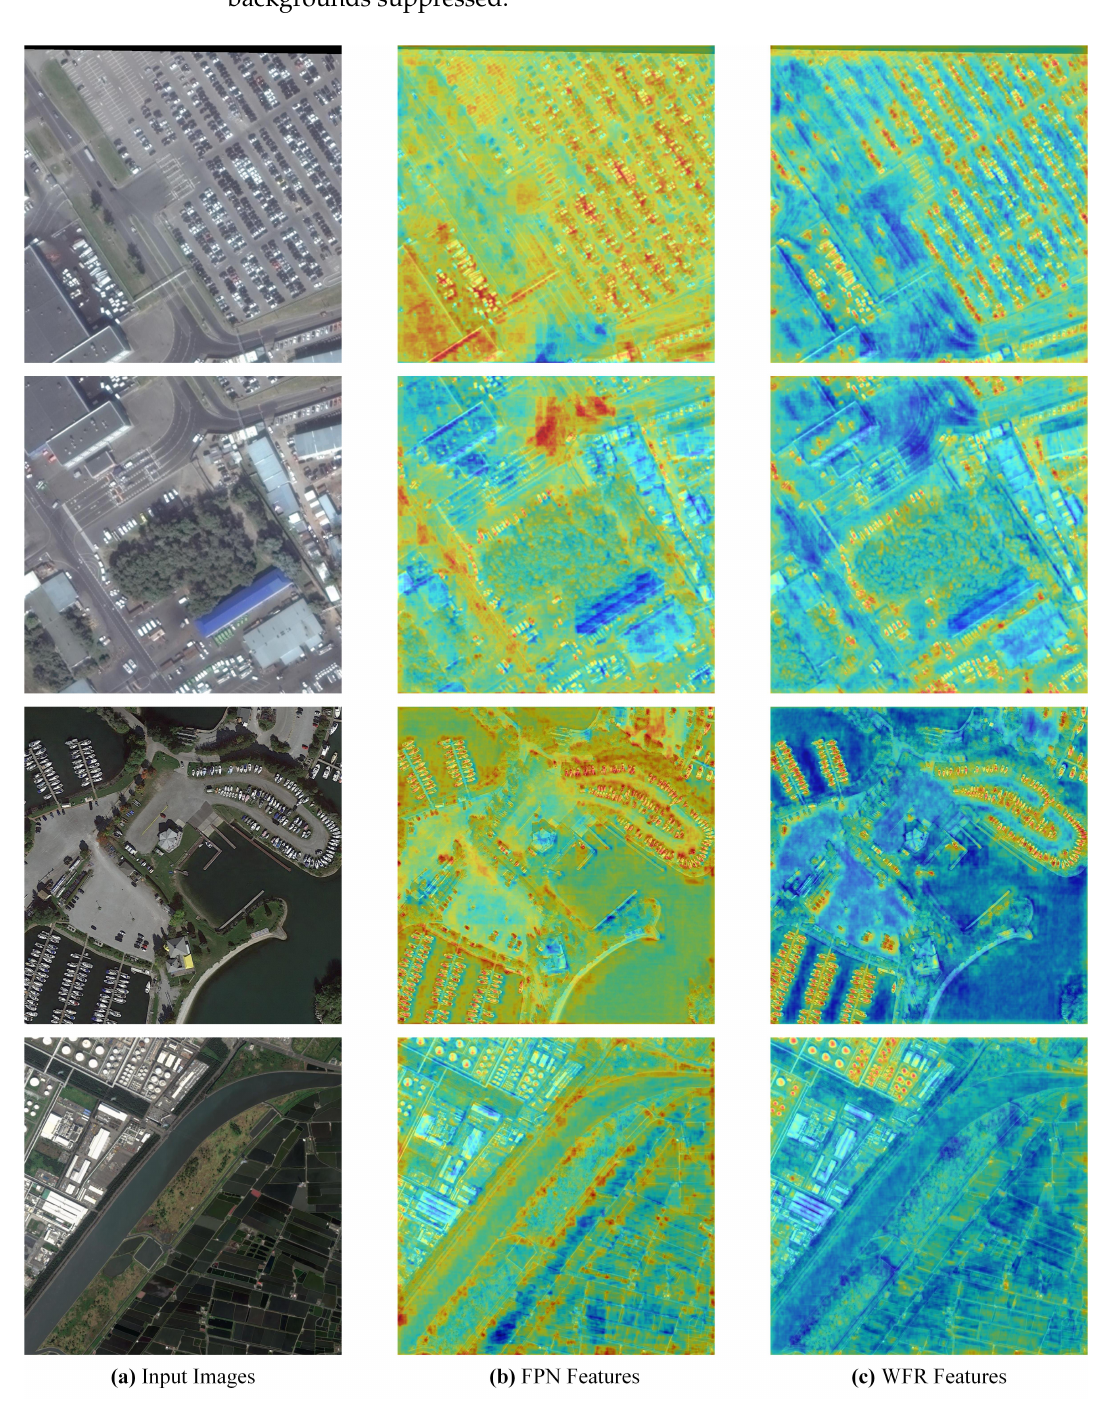
Figure 5. The features produced by FPN and our WFR at the first pyramidal